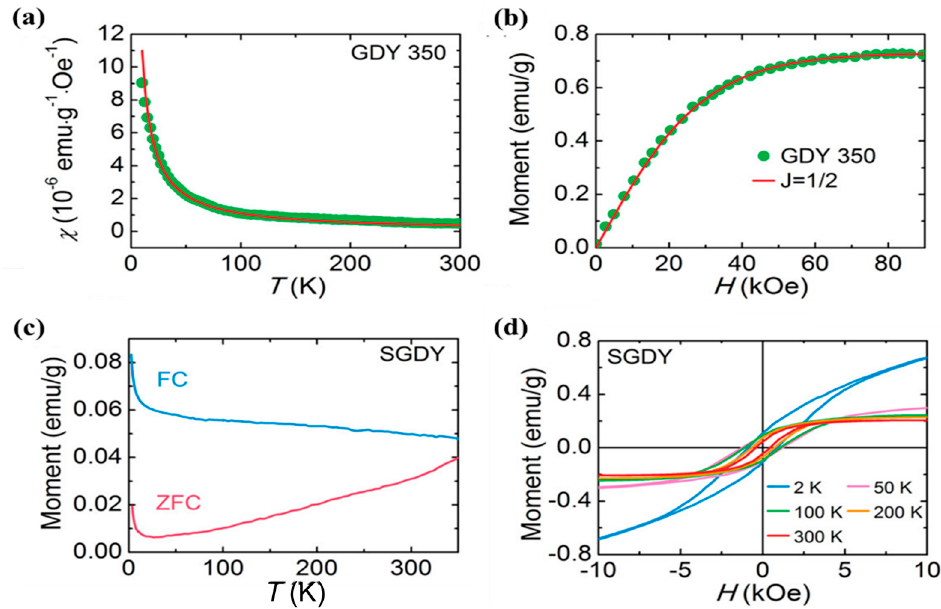
Figure 21. The χ -T relationship examined in a temperature range of 2–300 K ( a ) and an M-H curve taken at 2 K for GDY 350 ( b ). Temperature–magnetization relationship, where FC is field cooled mode and ZFC–zero field cooled mode ( c ) and hysteresis loops recorded for S-doped GDY ( d ). Reproduced with permission [177]. Copyright 2019, American Chemical Society.